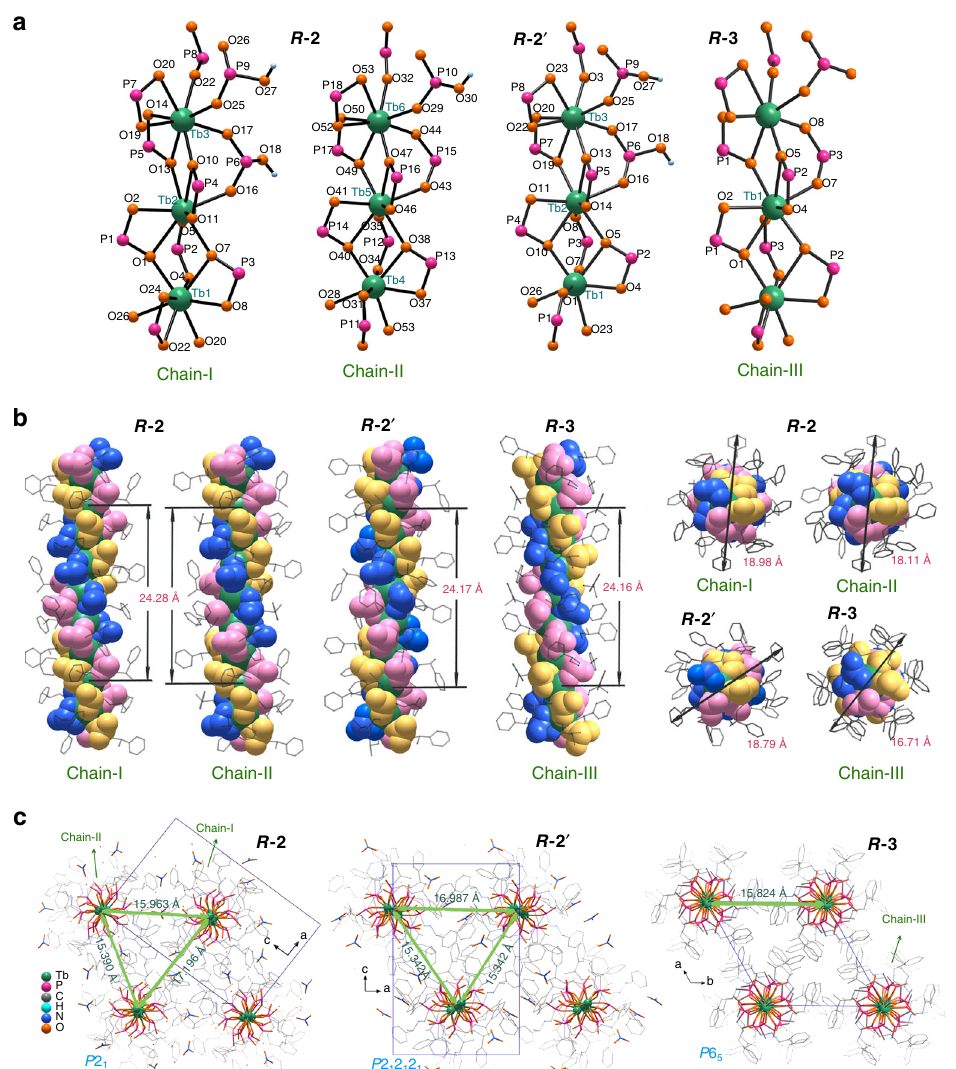
Fig. 3 Crystal structures of R -2 , R -2 ′ and R -3 . a Chain structures with atomic labelling in R -2 , R -2 ′ and R -3 along the crystallographic 2 1 or 6 5 screw axis. The N and C atoms are omitted for clarity. b Side and top views of the chains in structures R -2 , R -2 ′ and R -3 , which contain left-handed triple strands. The pitches and diameters of each helical chain are also given. c Packing diagrams of structures R -2 , R -2 ′ and R -3 viewed along the crystallographic b - or c -axis. The interval of adjacent chains are de fi ned by the distances between the relative 2 1 axis along the b -direction in R -2 and R -2 ′ or 6 5 axis along the c -direction in R